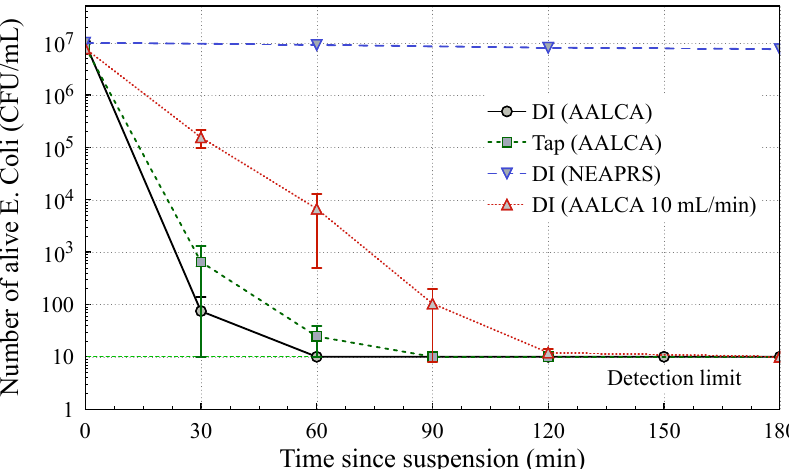
Figure 9. Dependency of the number of surviving bacteria on the duration of incubation after mixture of E. coli suspension with DI or tap water treated with AALCA, DI water treated with NEAPRS, or DI water treated with AALCA at a 10 mL/min flow.